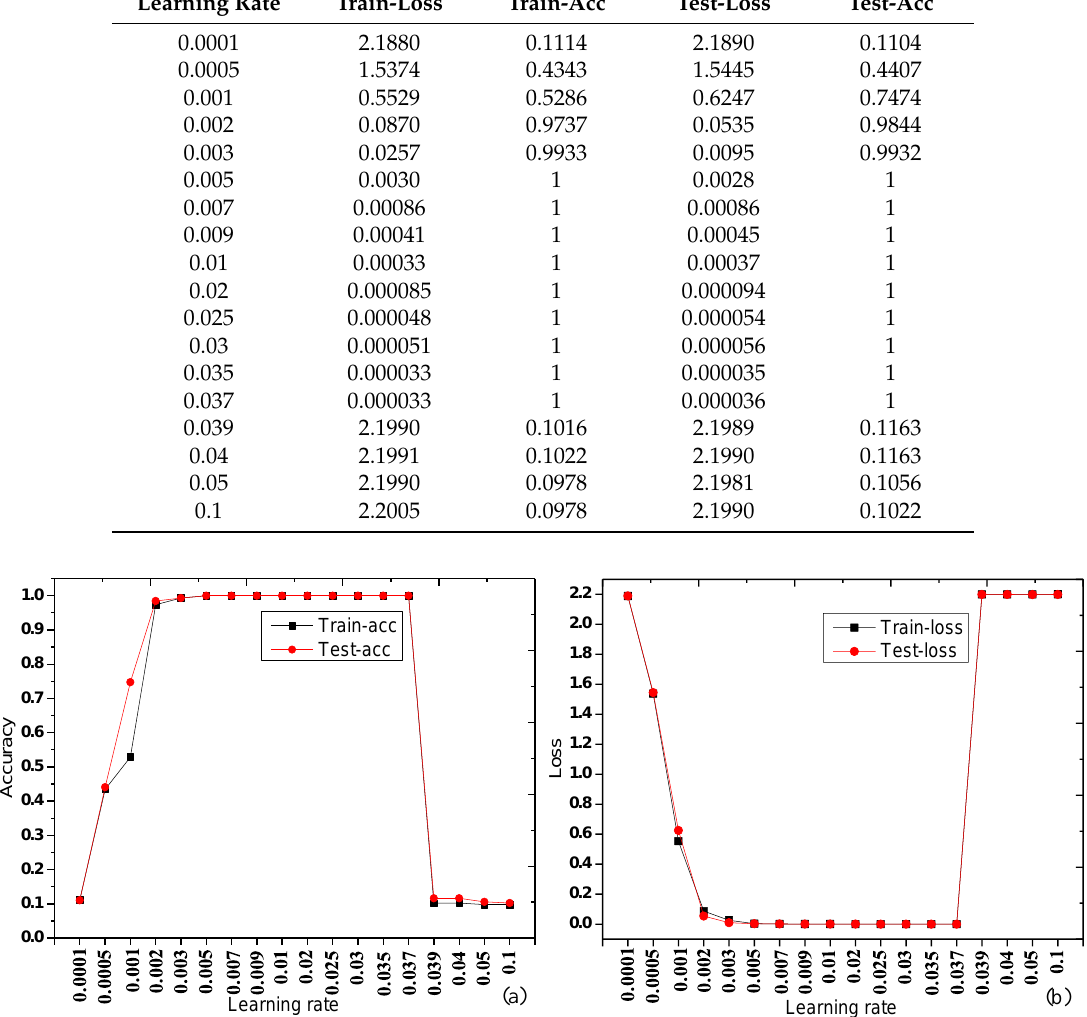
Figure 8. Training and testing results under different learning rates. ( a ) Accuracy; ( b ) loss.